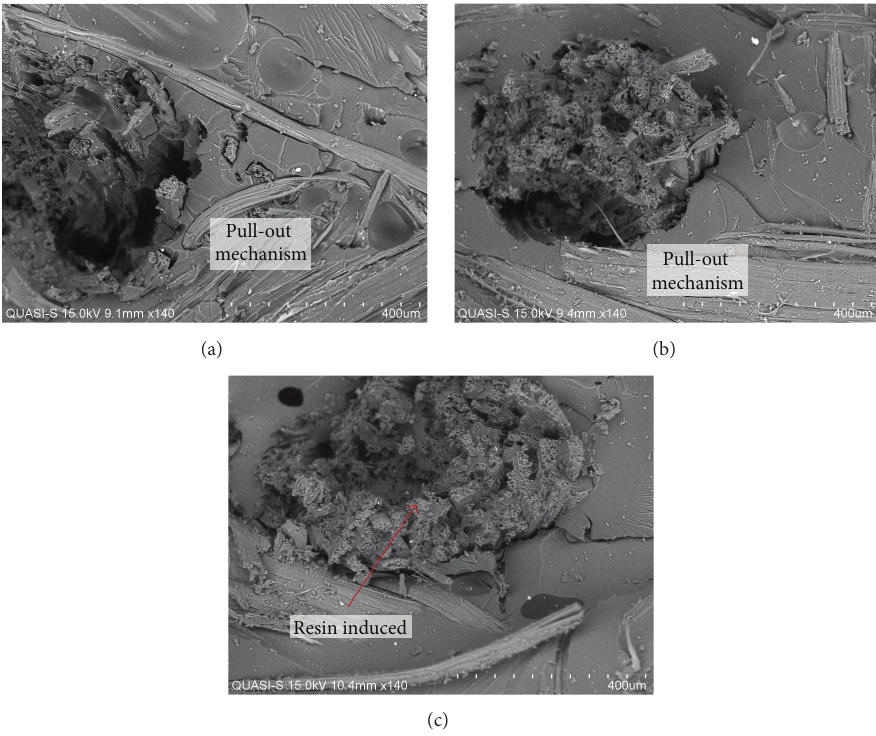
Figure 16: SEM analysis on sample 1 (type A) kenaf composites.